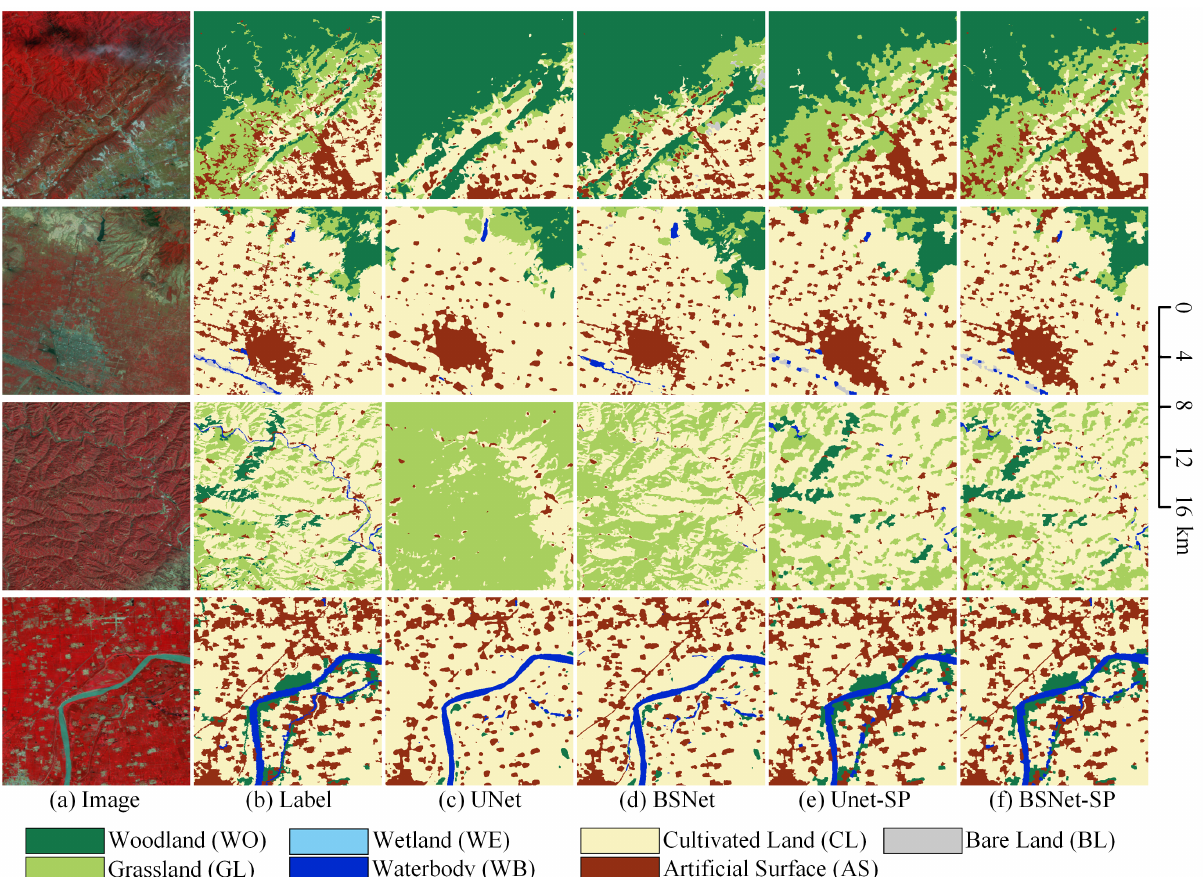
Figure 10. Ablation study with the block shuffle structure and superpixel branch on Landsat core dataset. ( a ) Landsat image. ( b ) Ground truth. Inference result of ( c ) the UNet, ( d ) the UNet with the block shuffle structure (BSNet), ( e ) the UNet with the superpixel branch (UNet-SP), and ( f ) the BSNet with the superpixel branch